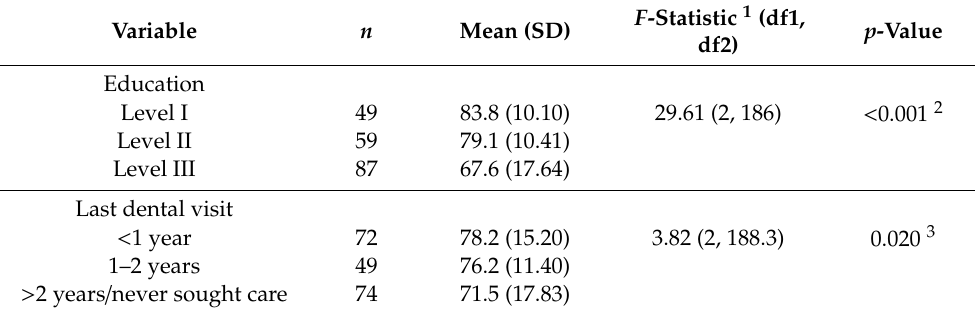
Table 3. Comparison of total OHLI-M scores by education level and last dental visit ( n = 195).